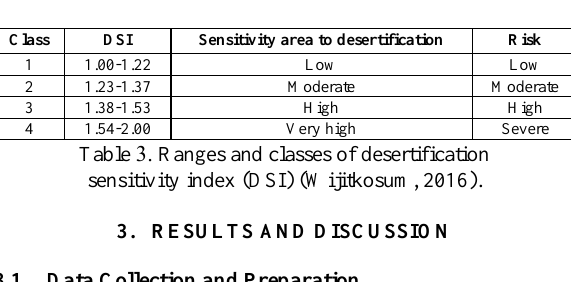
Table 2. Quantitative scores and qualitative classes of considered indicators